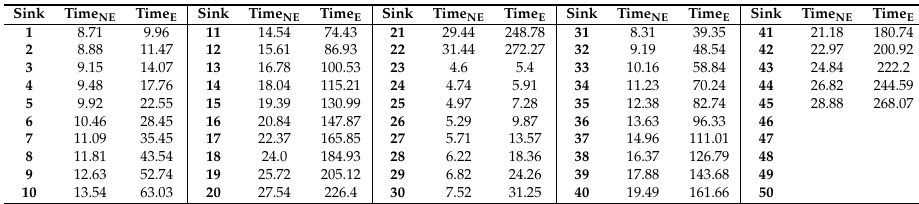
Table A1. Scenario 1: transmission times (in s) for each sink all over the transmission line. (Distance between poles is equal to 50 m, κ = 2, η = 22, η = 23, NE means no encryption, E means encryption.)